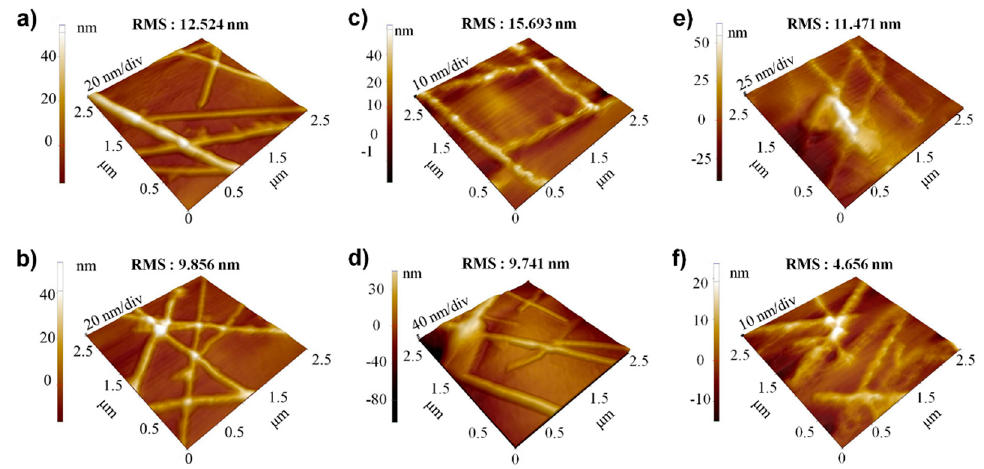
Figure 3. AFM images. ( a ) AgNWs before annealing, ( b ) annealed AgNWs, ( c ) GCA 1:1 –AgNW before annealing, ( d ) GCA 1:1 –AgNW after annealing, ( e ) GCA 2:1 –AgNW before annealing, ( f ) GCA 2:1 –AgNW after annealing.